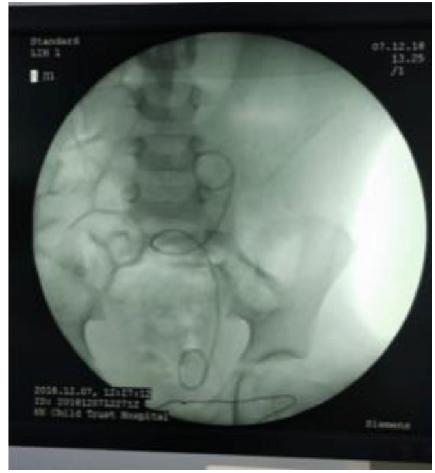
Figure 4: Xray KUB showing JJ stent across the left PUJ.